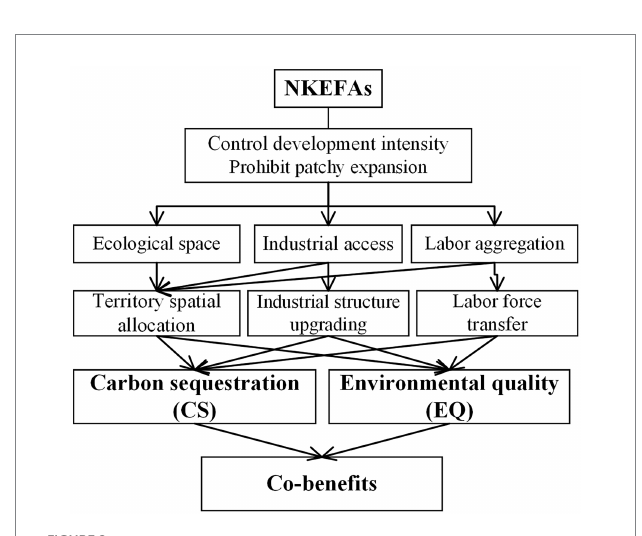
FIGURE 2 The framework of NKEFAs affecting CS and EQ.